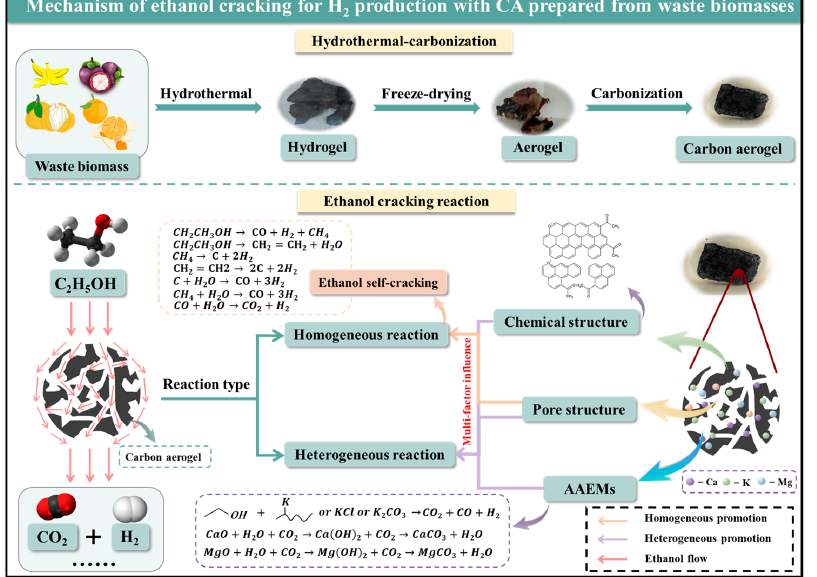
Figure 7. Mechanism of ethanol cracking for H 2 production with CAs prepared from waste bio- masses.